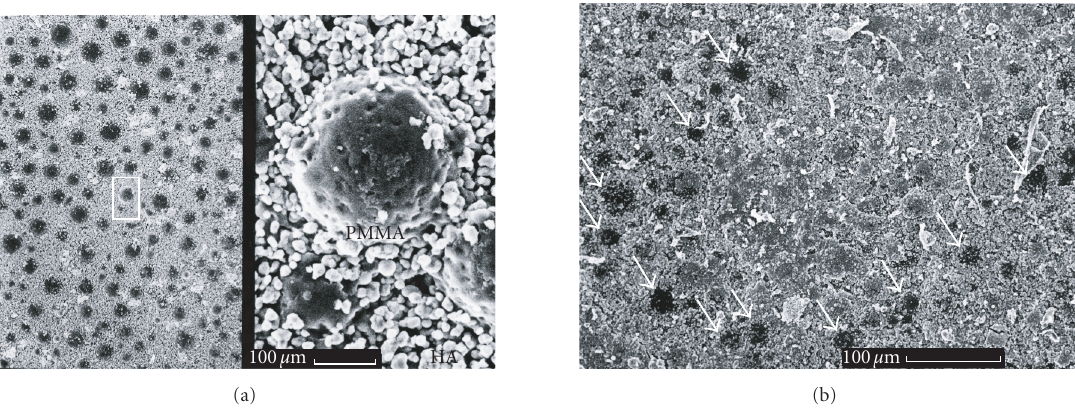
Figure 3: Surfaces of a polymethylenemethacrylate (PMMA)-hydroxyapatite(HA) composit (bone cement, Osteopal) which were incubated in PBS without FCS (a) and DMEM culture solution supplemented by 20% FCS (b) for 4 weeks. The latter probe showed a protein adsorption in SEM whereas the sample which was exposed in serum-free PBS showed no protein layer on its surface. Figure 2b demonstrates the di ff erent protein-adsorbing potency between PMMA and HA. All HA granules were covered by protein deposition whereas some PMMA “balls” (arrows) were